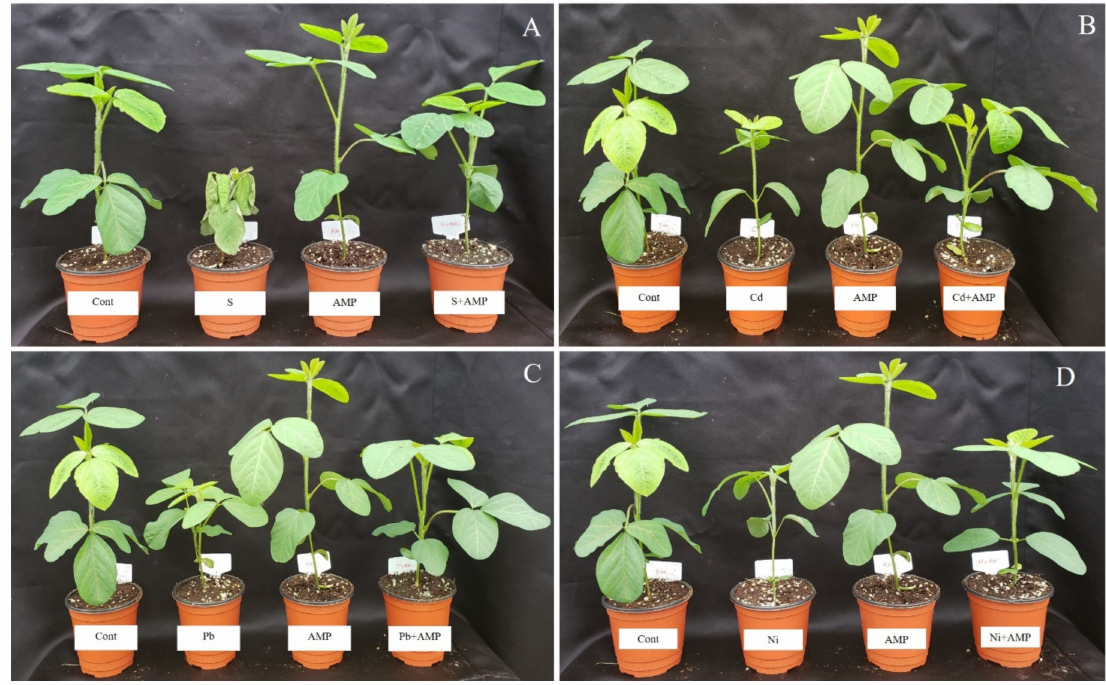
Figure 1. Effects of ampelopsin application on soybean plant growth under normal and stress conditions after 12 days of treatment (12DAT; ( A–D )). Treatments: Cont (control), AMP (1 µ M ampelopsin), S (1.5% sodium chloride), AMP (1 µ M ampelopsin) + S (1.5% sodium chloride), Cd (3 mM cadmium), 1 µ M AMP (ampelopsin) + Cd (3 mM cadmium), Pb (3 mM lead), AMP (1 µ M ampelopsin) + Pb (3 mM lead), Ni (3 mM nickel), and AMP (1 µ M ampelopsin) + Ni (3 mM nickel). Values show the means ± SE ( n = 5) and significant differences at p < 0.05 (Tukey